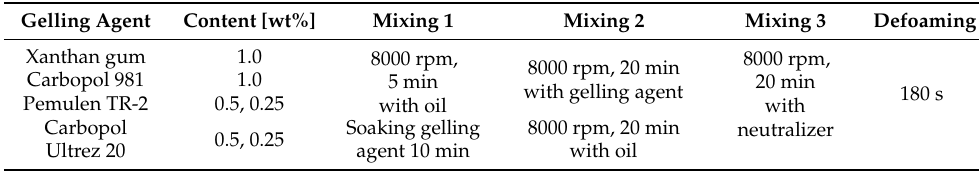
Table 1. Emulsion preparation